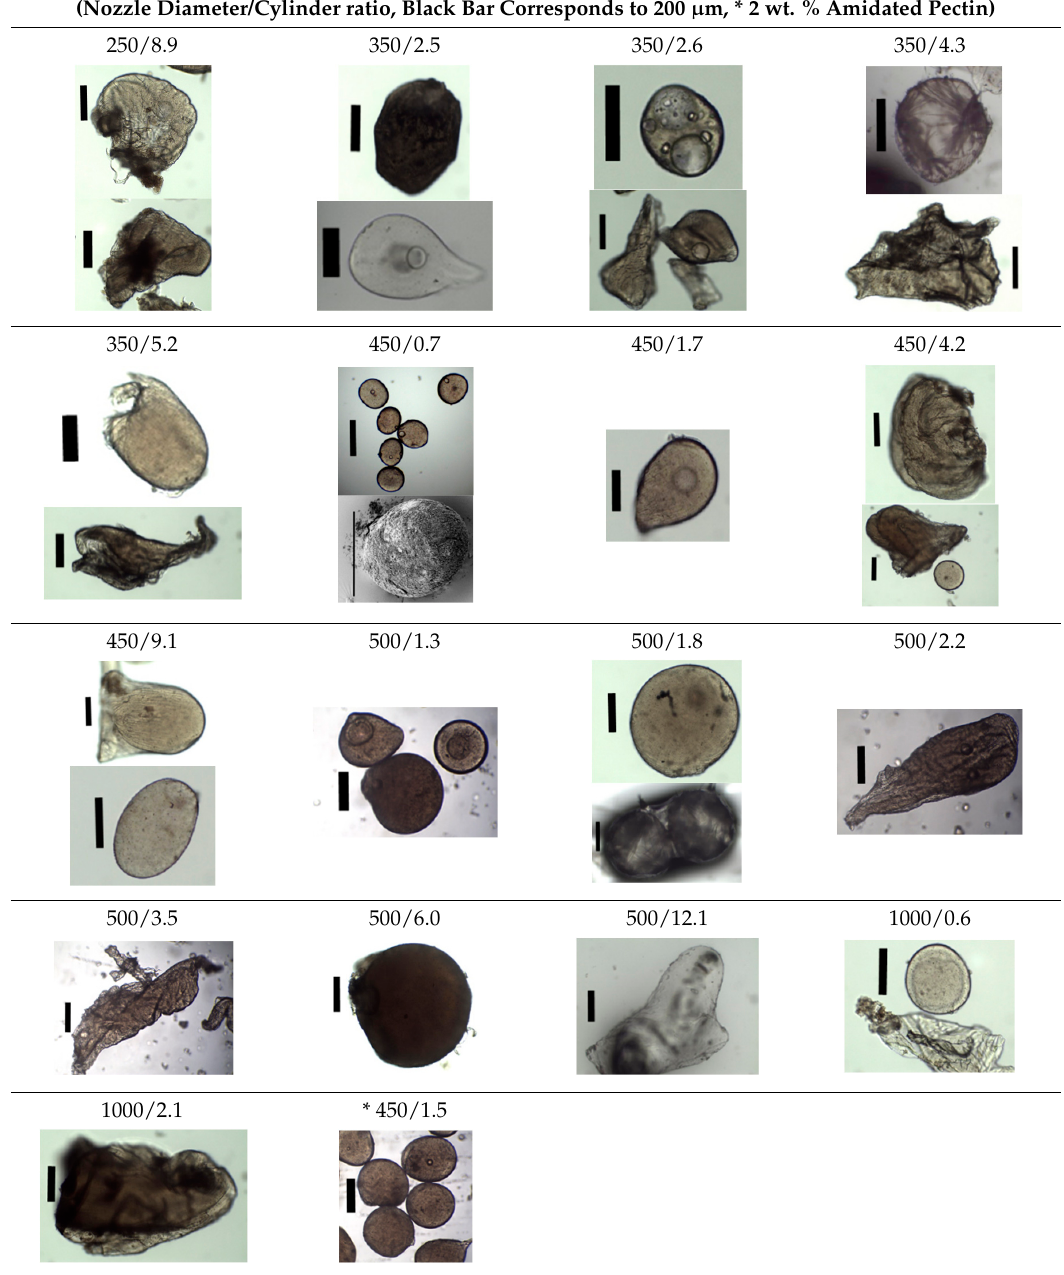
Table 3. Used combinations of nozzle diameters and cylinder ratios for the production of gel particles via the diffusion method.